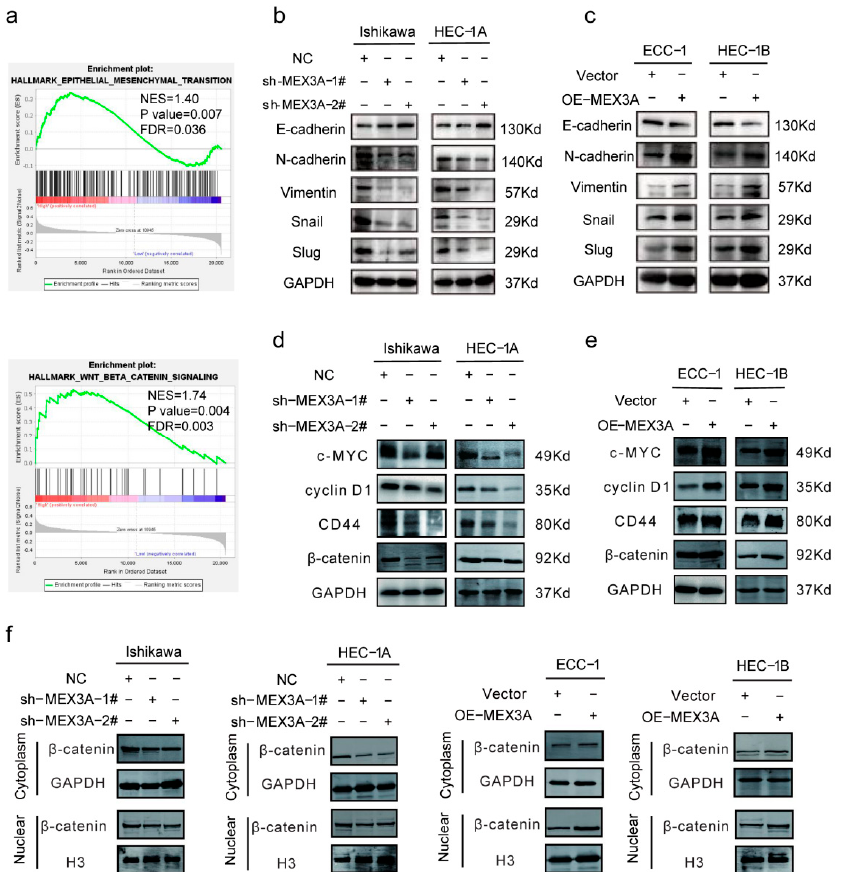
Figure 4. MEX3A activates the EMT and Wnt/ β -catenin signaling pathway. ( a ) GSEA of the groups expressing MEX3A at high and low levels in TCGA. ( b , c ) The expression levels of EMT-related genes were investigated via Western blotting in both MEX3A-knockdown and -overexpression cell lines. ( d , e ) The protein levels of β -catenin and its downstream targets were explored via Western blotting in both MEX3A-knockdown and MEX3A-overexpression cells. ( f ) The role of MEX3A on nuclear and cytoplasmic β -catenin in MEX3A knockdown and overexpression cells was measured using Western blotting.